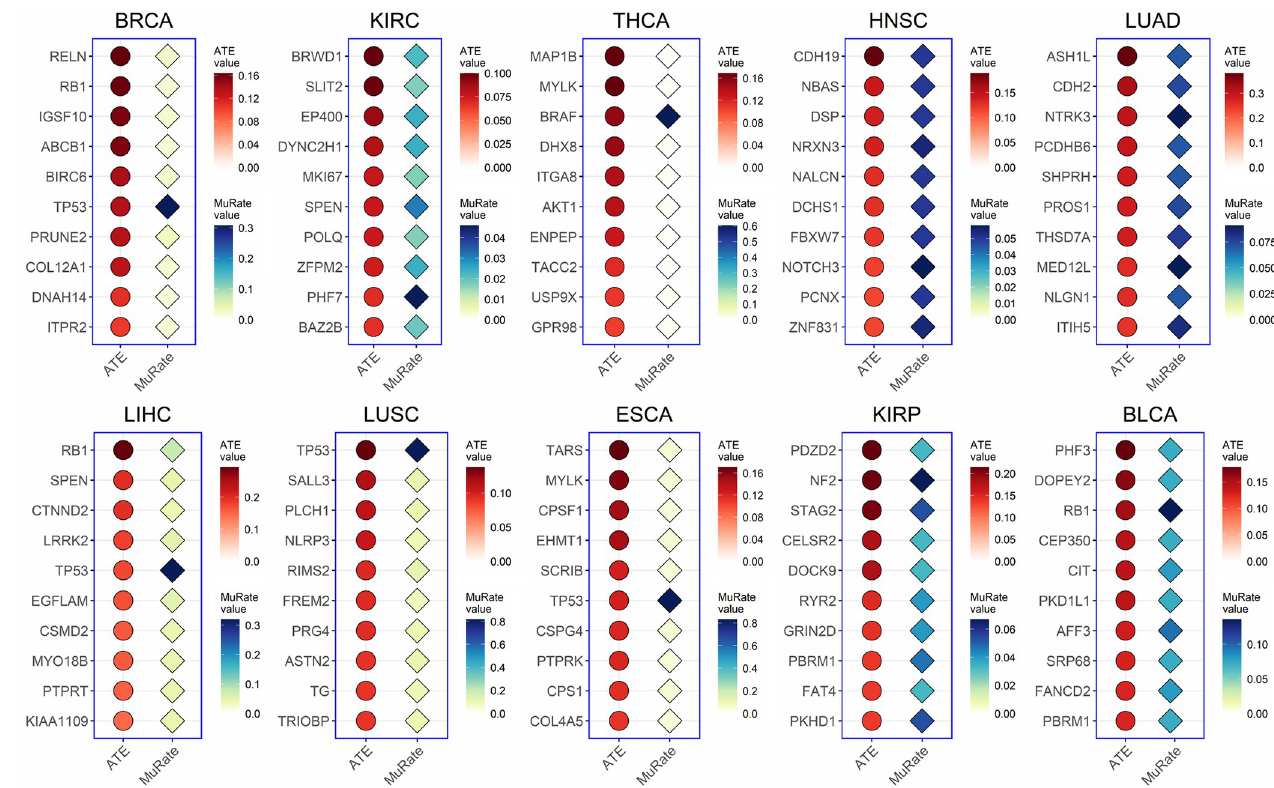
Fig 3. Top 10 mutations with the highest causal effect on DNA replication in 10 cancers. The figure shows the ATE value and the mutation rate of each predicted key mutation.